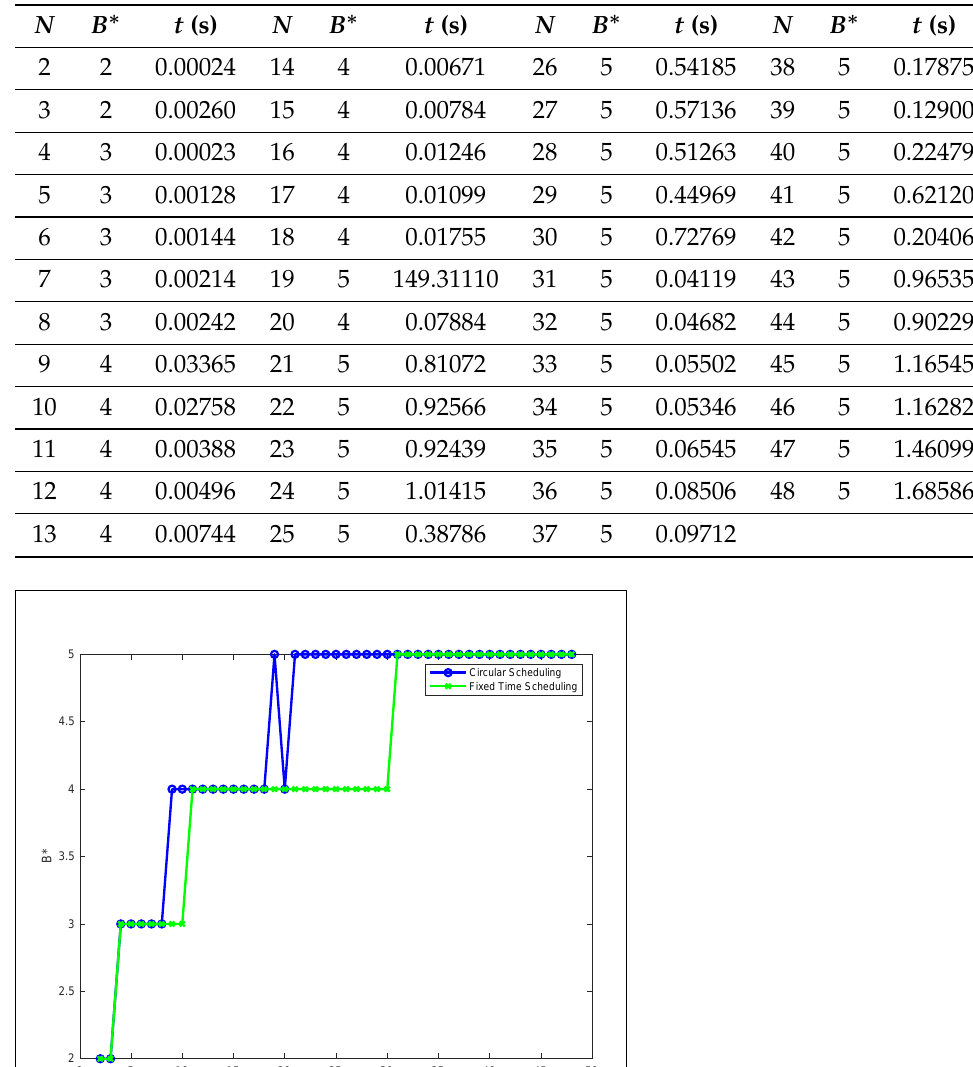
Table 3. Optimal bandwidth B ∗ for 47 instances of N = C .